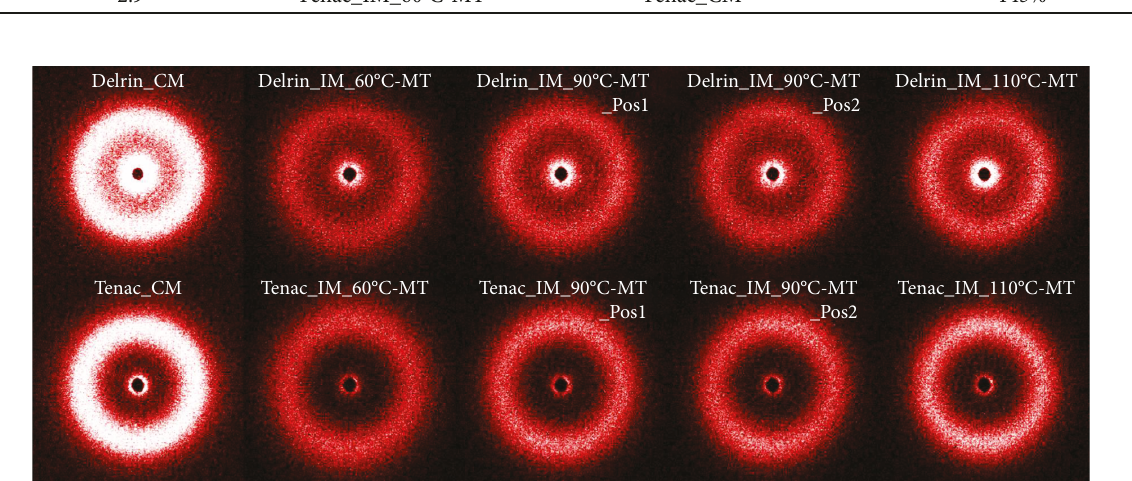
Figure 13: Representative SAXS patterns obtained for the di ff erent processing conditions.